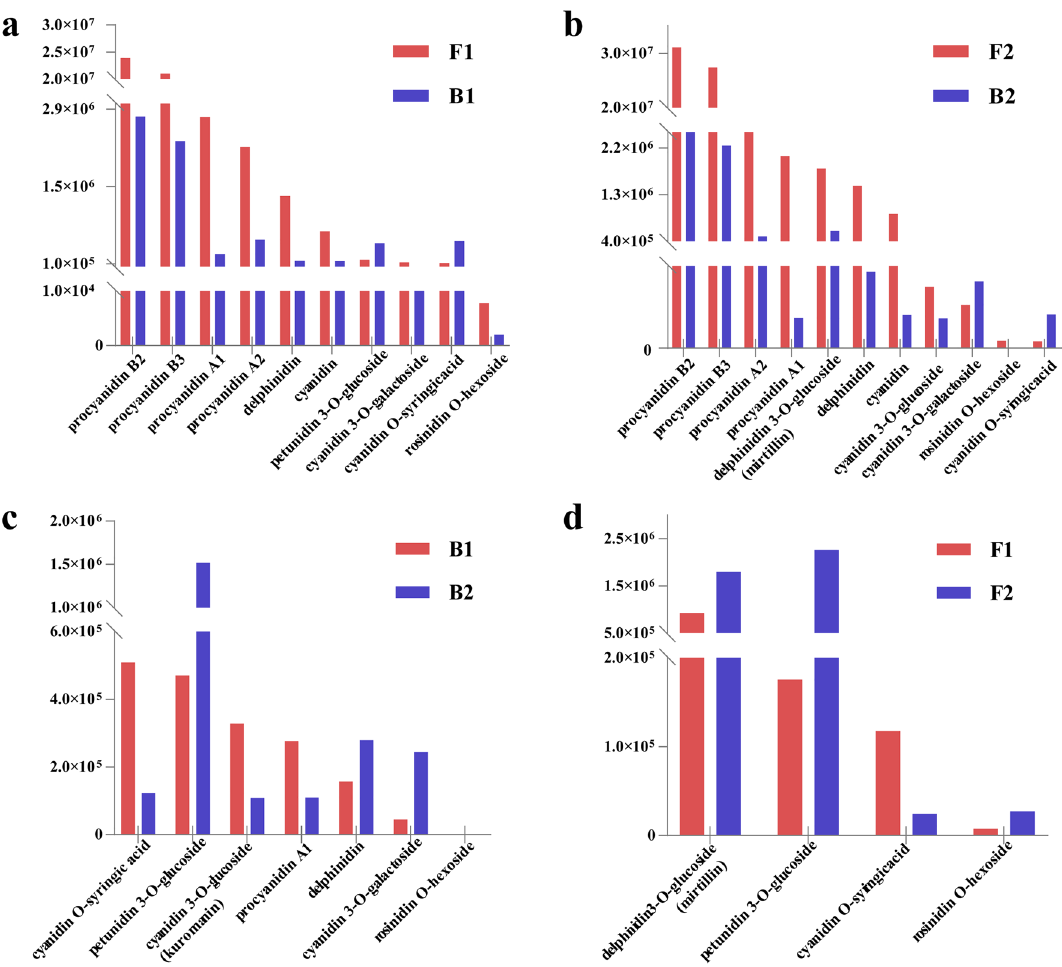
Figure 2. Types and relative contents of flavonoids in different areas of peanut testa at different developmental stages. ( a , b ) represent the type and content differences of metabolized flavonoids between the pigmented and non-pigmented areas after DAF30 and DAF45, respectively. ( c ) represents the different metabolized flavonoid types and content in the non-pigmented areas after DAF30 and DAF45. ( d ) represents the different metabolized flavonoid types and content in the pigmented areas at DAF30 and DAF45. The horizontal axis represents the types of flavonoids in the variegated testa and the vertical axis represents the peak areas value determined by the LC–MS/MS detection